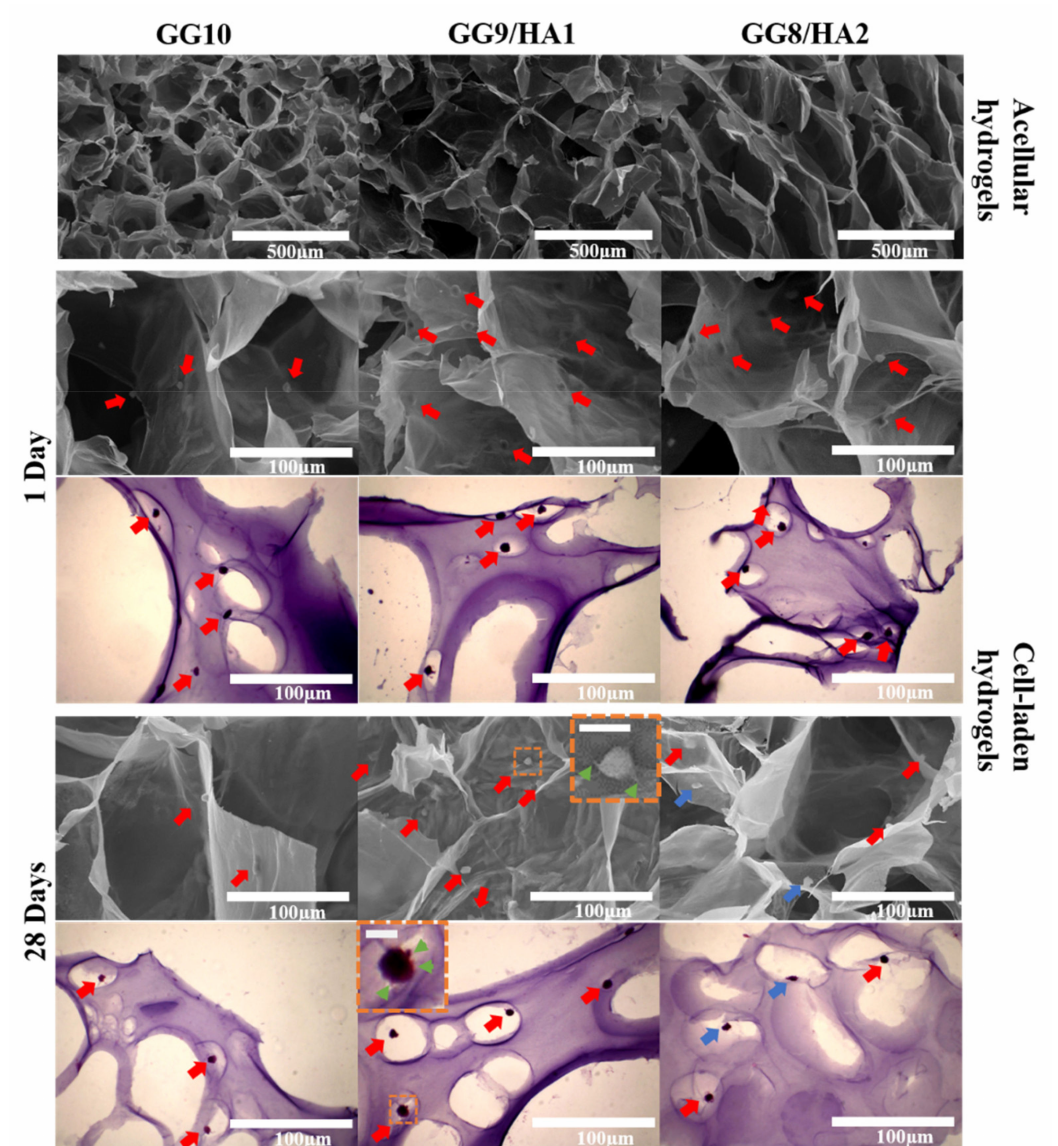
Figure 4. Morphological observation of the acellular and cell-laden hydrogels under SEM analyzed after 1 and 28 days of culture. The suspension of cells in the porous structure (marked in red arrows), enhanced cell–matrix interactions (shown in orange box), secreted extracellular matrix (marked in green arrows), and deformed cell shapes (marked in blue arrows) were